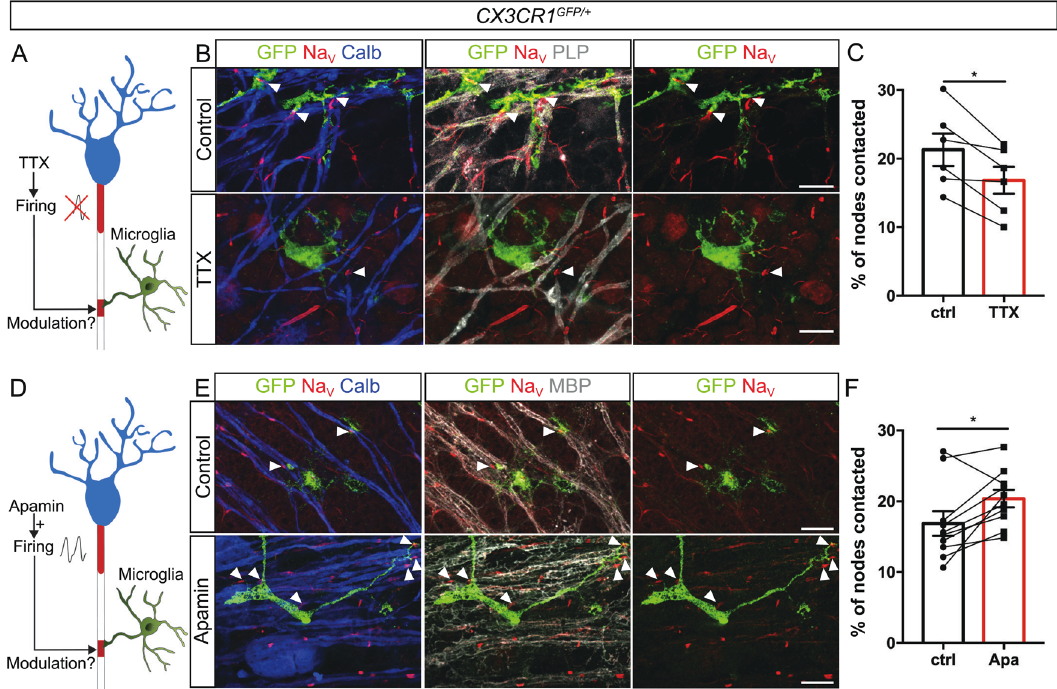
Fig. 5 Neuronal activity modulates microglia-node of Ranvier interaction. A , D Experimental designs. B , C In myelinated CX3CR1 GFP/ + cerebellar organotypic slices, microglia (GFP, green) contacts with nodes (Na V , red) are reduced following electrical activity inhibition with tetrodotoxin (TTX). E , F They are conversely increased following electrical activity activation using apamin (Apa). Arrowheads show the nodes of Ranvier contacted by microglia. C , F Percentage of nodes of Ranvier contacted by microglial cells in control (ctrl) vs 1-h treated slices from the same animal ( B – C ) TTX (500 nM, n = 6 animals), E , F Apamin (500 nM, n = 10 animals). Scale bars: B , E 10 µ m. C Two-sided Paired t-test; F Two-sided Wilcoxon matched pairs test. * P < 0.05, ** P < 0.01, *** P < 0.001, **** P < 0.0001, ns not signi fi cant; bars and error bars represent the mean ± s.e.m. For detailed statistics,